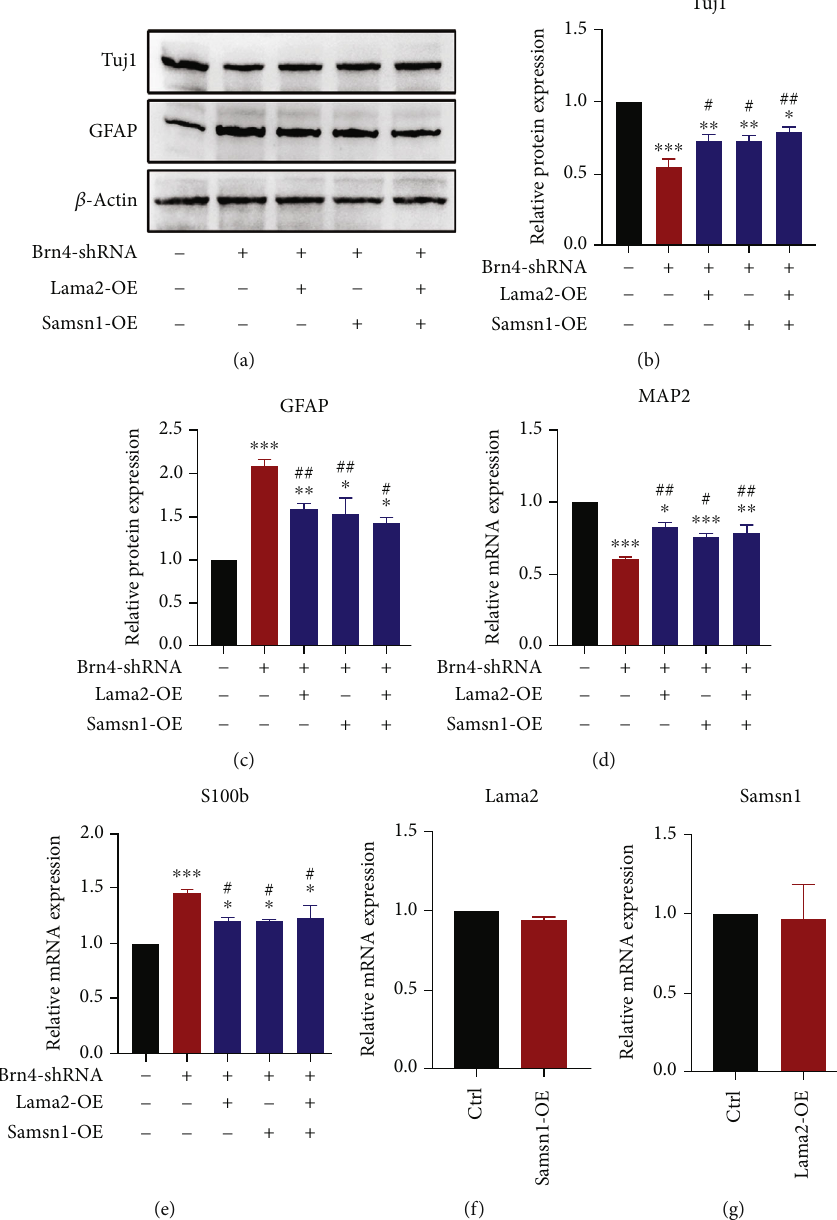
Figure 8: Lama2 and Samsn1 partially reversed the decrease of NSCs di ff erentiation into neurons caused by Brn4 knockdown. (a – c) Representative immunoblots of Tuj1, GFAP, and β -actin in the primary hippocampal NSCs after induced di ff erentiation for 7 days (a) and quanti fi cation of Tuj1 and GFAP protein levels normalized to β -actin (b, c). (d, e) Quanti fi cation of MAP2 and S100b mRNA levels normalized to β -actin after the NSCs induced di ff erentiation for 7 days. (f, g) Quanti fi cation of Lama2 and Samsn1 mRNA levels normalized to β -actin. Error bars represent the mean ± SEM . n = 3 . ∗ P < 0 : 05 , ∗∗ P < 0 : 01 , and ∗∗∗ P < 0 : 001 vs. Ctrl; # P < 0 : 05 and ## P < 0 : 01 vs.